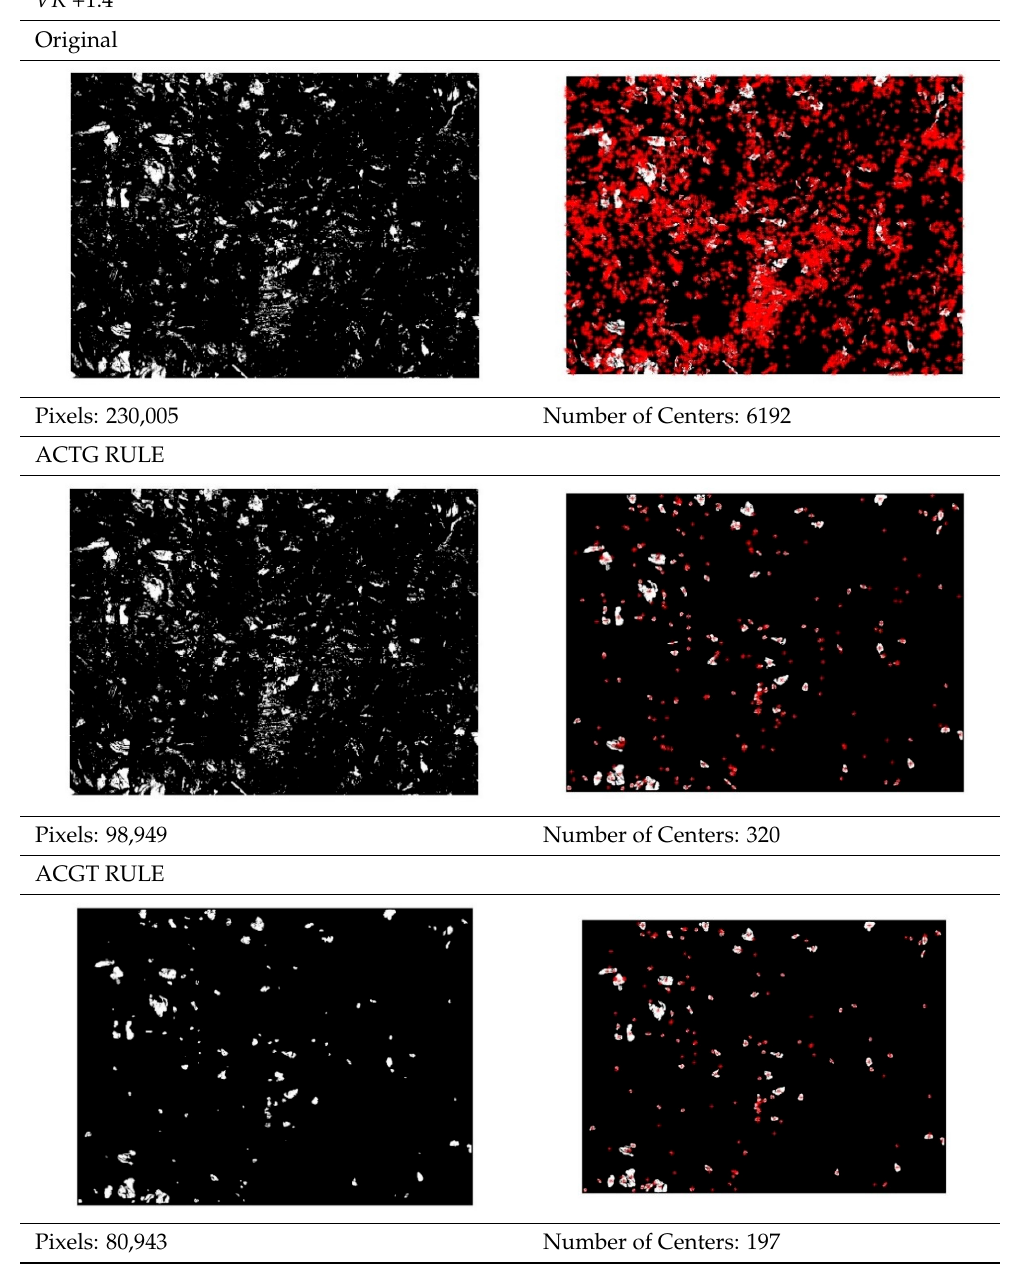
Table A5 . Images and associated pixels and number of centers corresponding to VR = +1.4.